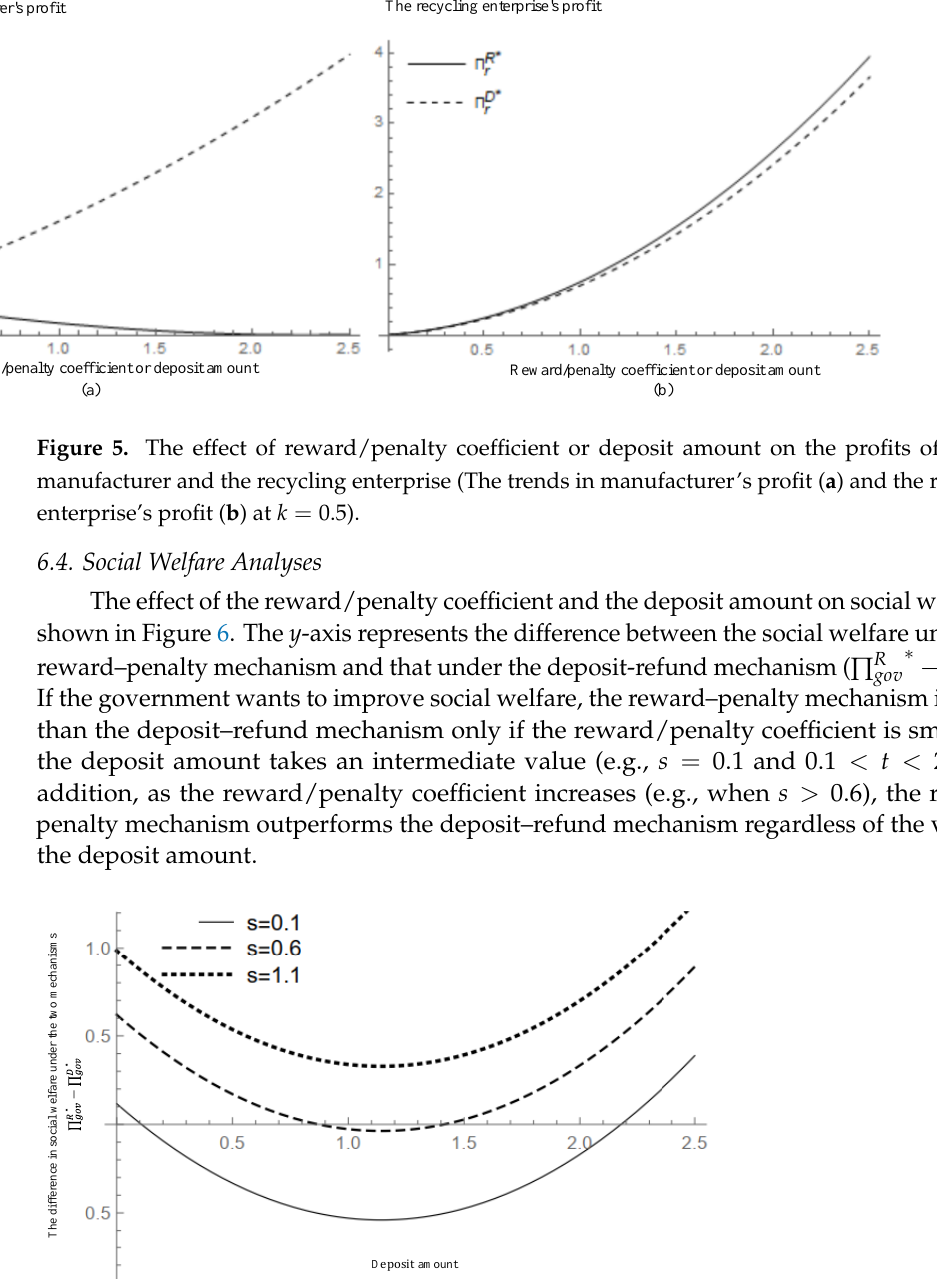
Figure 5. The effect of reward/penalty coefficient or deposit amount on the profits of the EV manu- facturer and the recycling enterprise (The trends in manufacturer´s profit ( a ) and the recycling en- terprise´s profit ( b ) at 𝑘 = 0.5 ).